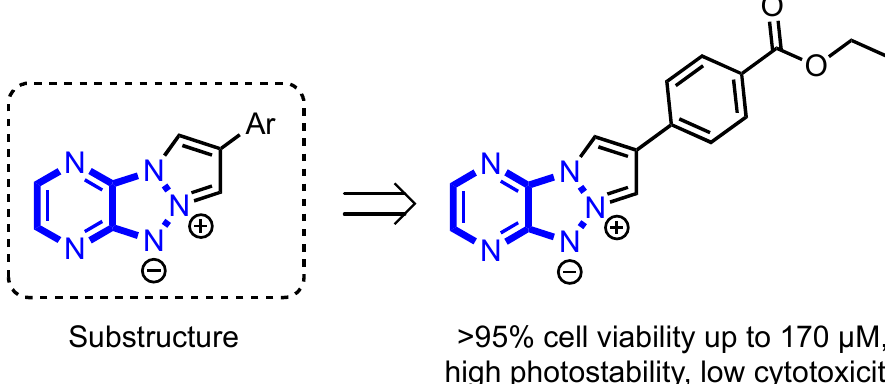
Figure 4. A novel class of small molecule fluorescent probes developed by Sirbu and coworkers [20] for use in optical and/or cellular imaging.